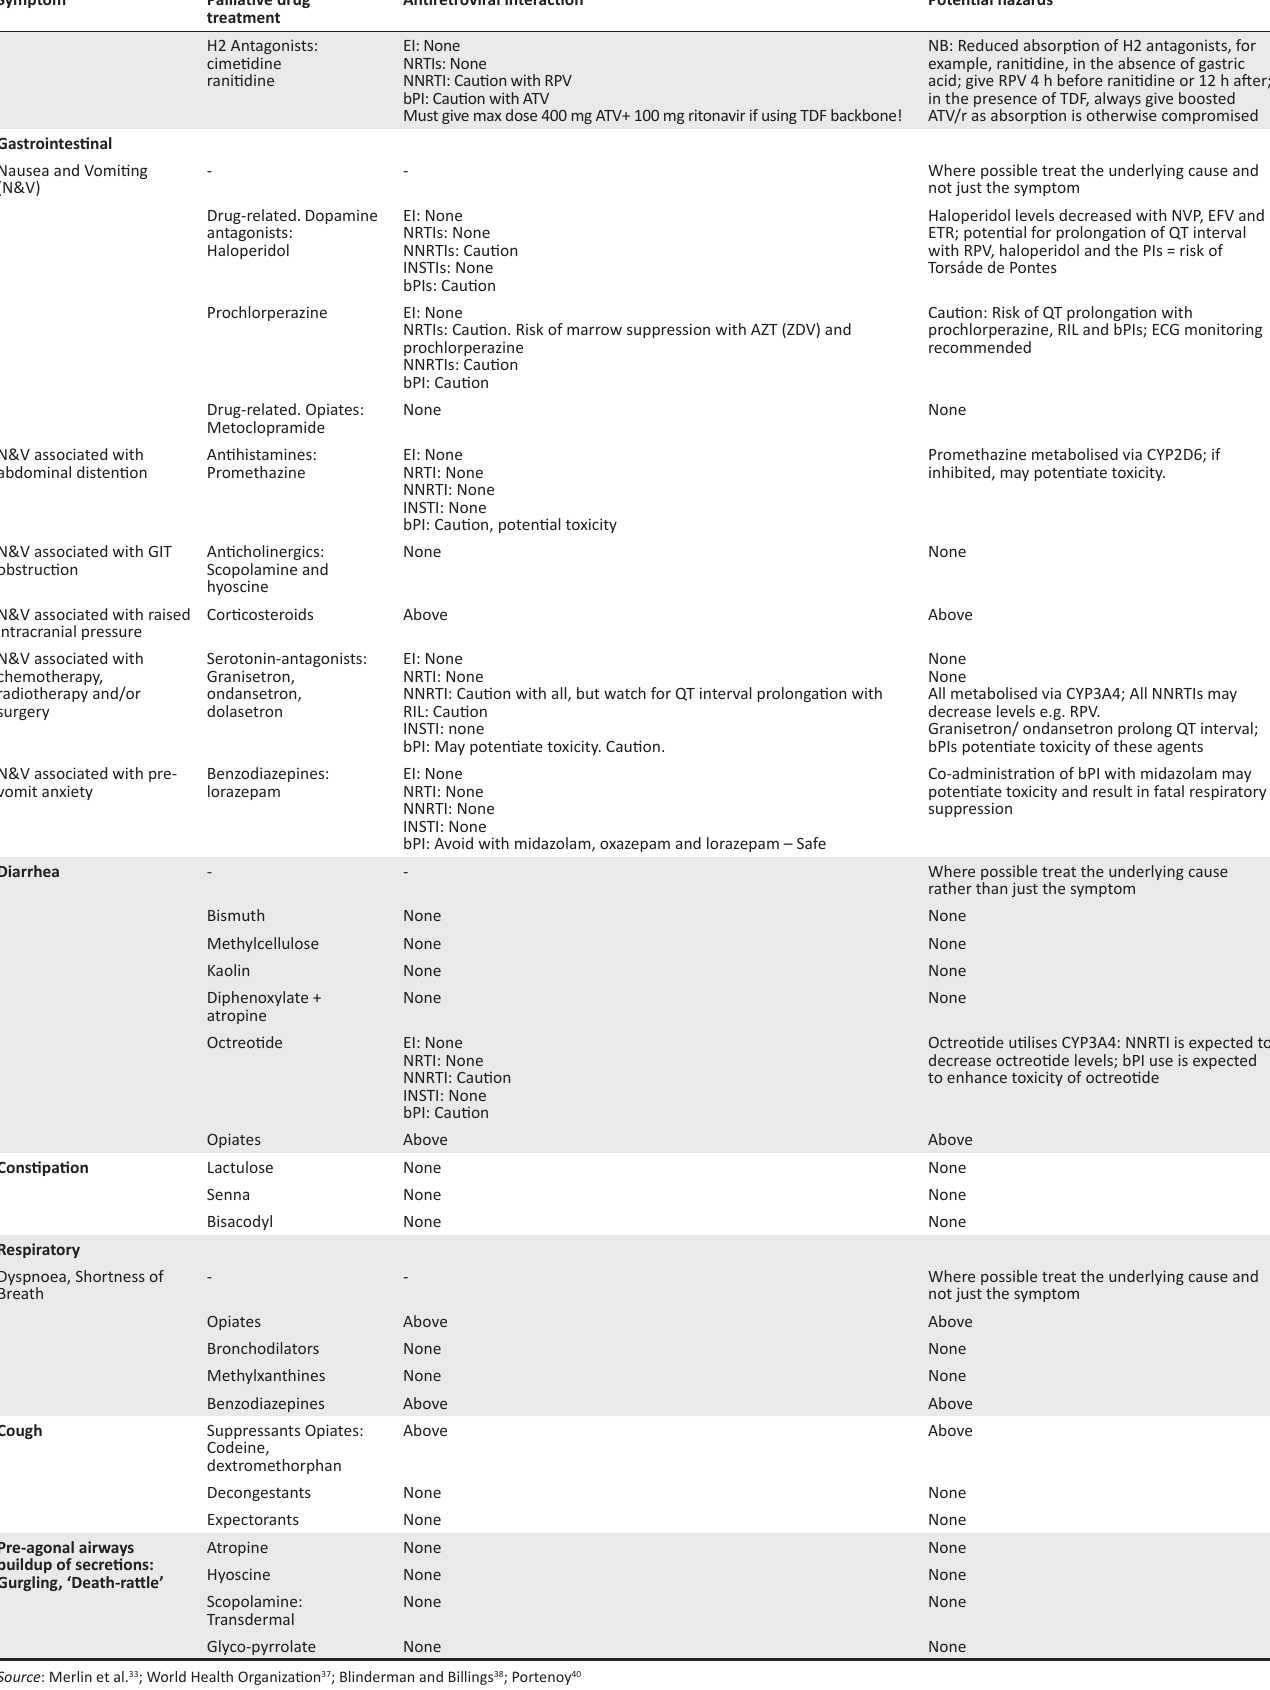
TABLE 1-A6 (Continues ...): Palliative care management, drug–drug interactions. Symptom Palliative drug Antiretroviral interaction Potential treatment